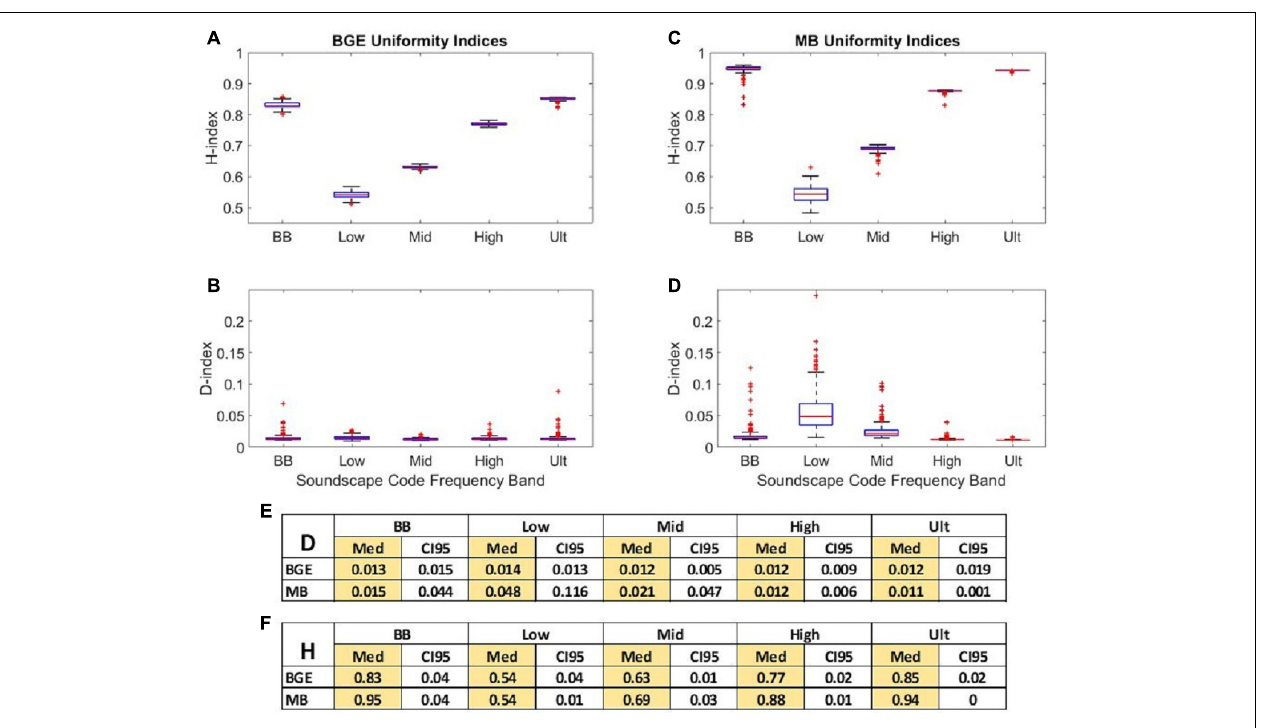
FIGURE 9 | Uniformity comparison U1 results. H-index values for (A) BGE and (C) MB sites; D-index values for (B) BGE and (D) MB sites; Red horizontal line indicates median value, outer edges of boxes represent 25th and 75th percentiles, whiskers mark boundary that contains approximately 99% of data values, and the red points are outliers. Corresponding soundscape code results for (E) the D-index at BGE and MB, and (F) the H-index at BGE and MB report the median (med) and size of the 95% confidence interval